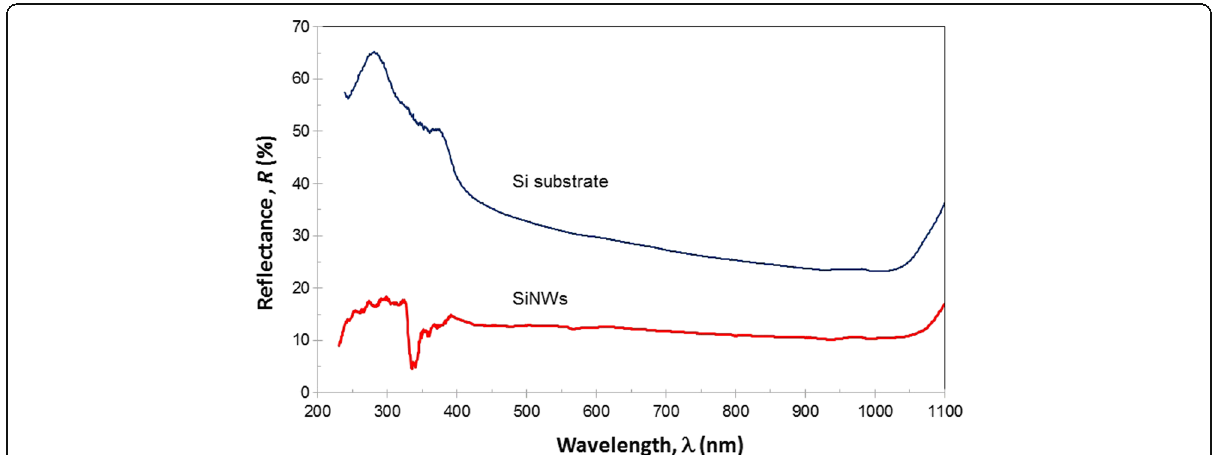
Fig. 6 Reflectance ( R ) versus wavelength ( λ ) for a Si substrate and the SiNW